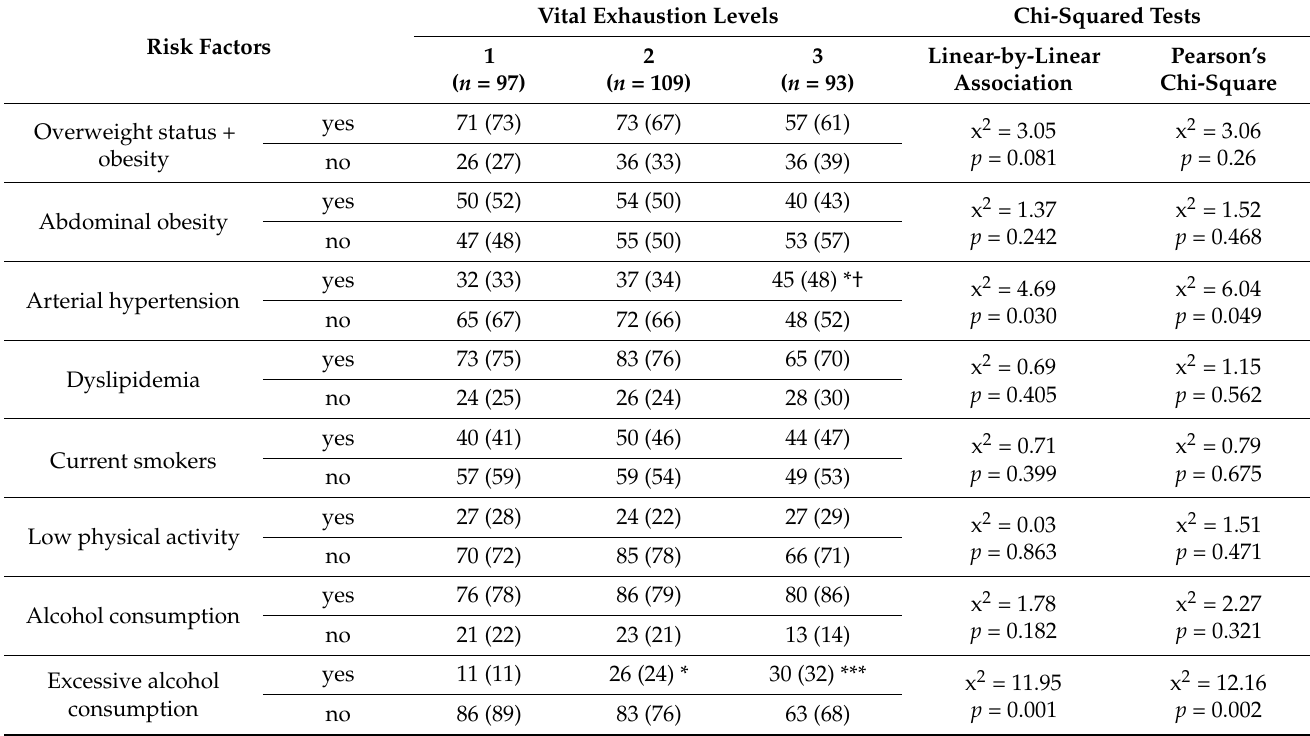
Table 1. Distribution of risk factors in groups of males with different vital exhaustion levels.